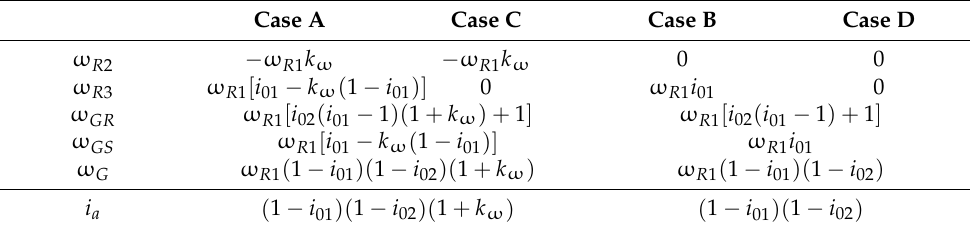
Table 1. The analytical expressions of the dependent kinematic parameters and the amplification kinematic ratio corresponding to the four cases (Figures 1 and